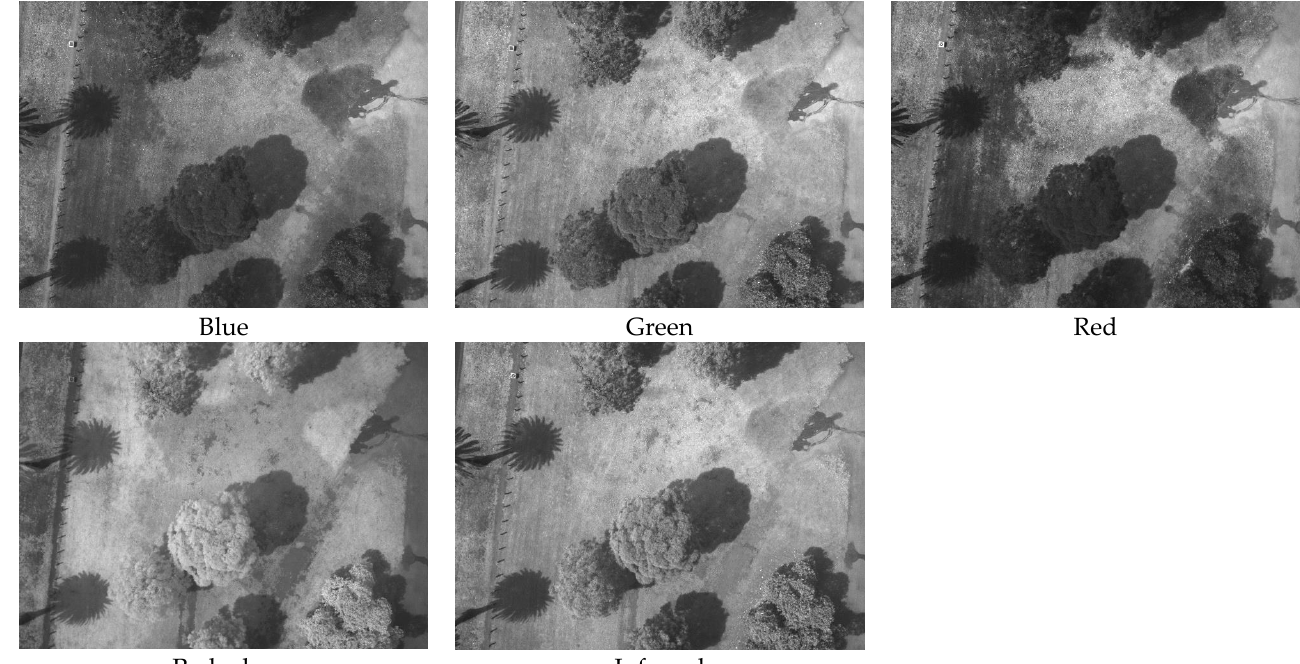
Figure 5. One of the multispectral images.